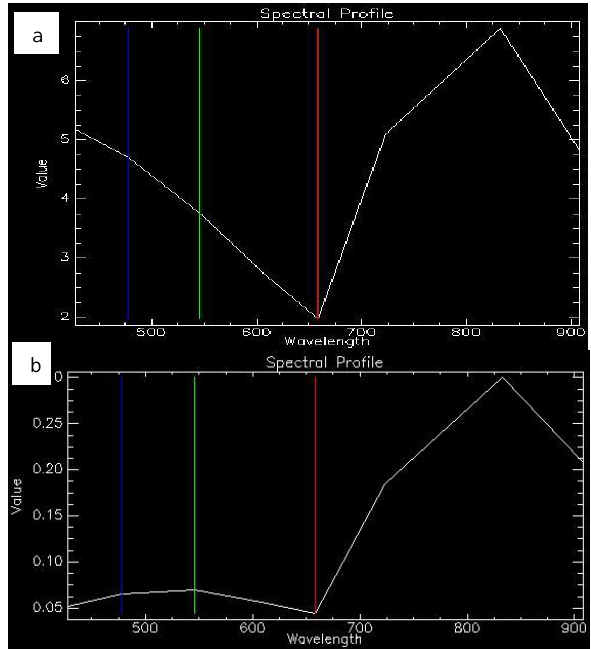
Figure 3. Radiance (a) and Surface reflectance (b) of healthy vegetation from healthy forest spectra.